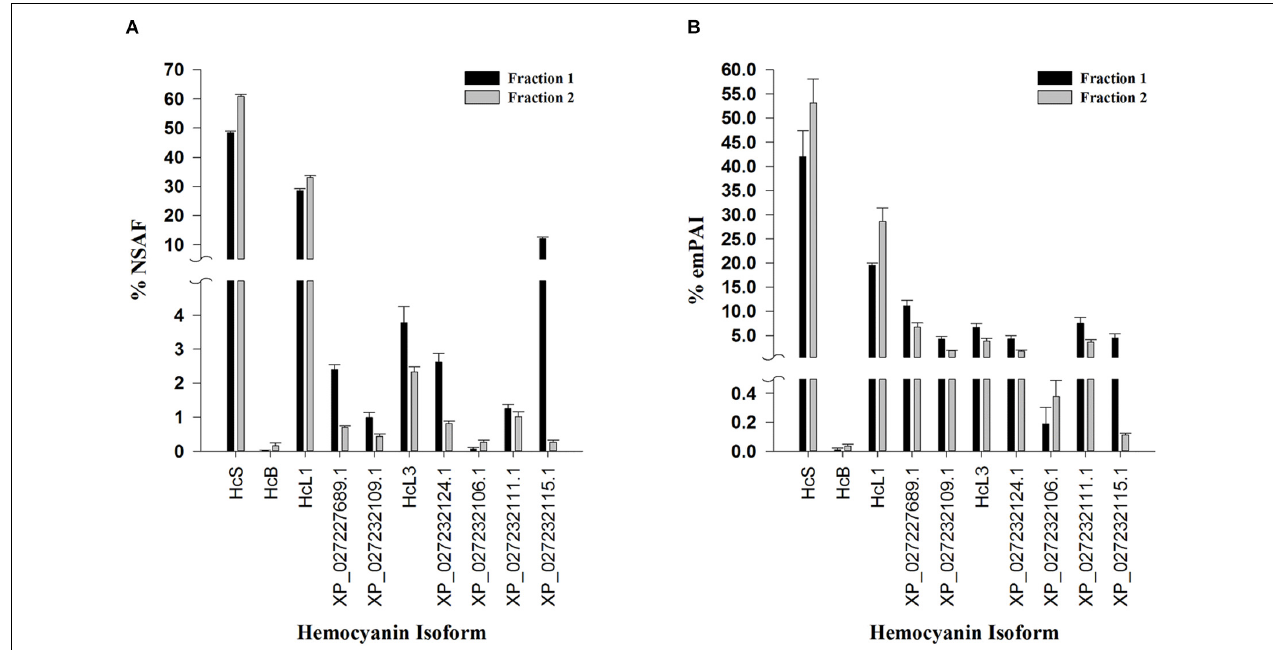
FIGURE 4 | Relative proportion of hemocyanin subunits identified in L. vannamei hemolymph by LC-MS/MS. Semi-quantitative values are listed as molar fractions (average ± SEM; n = 5) calculated from (A) NSAF and (B) emPAI values summed over all identified hemocyanins from the reference genome assembly ASM378908v1 (Zhang et al., 2019) or the translated L. vannamei transcriptome database (Johnson et al., 2015). All peptides and proteins were identified at < 1% protein FDR with 2 minimum peptides at < 1% local peptide FDR. Fraction 1 (black bars) and 2 (gray bars) represent dodecamer and hexamer fractions respectively.